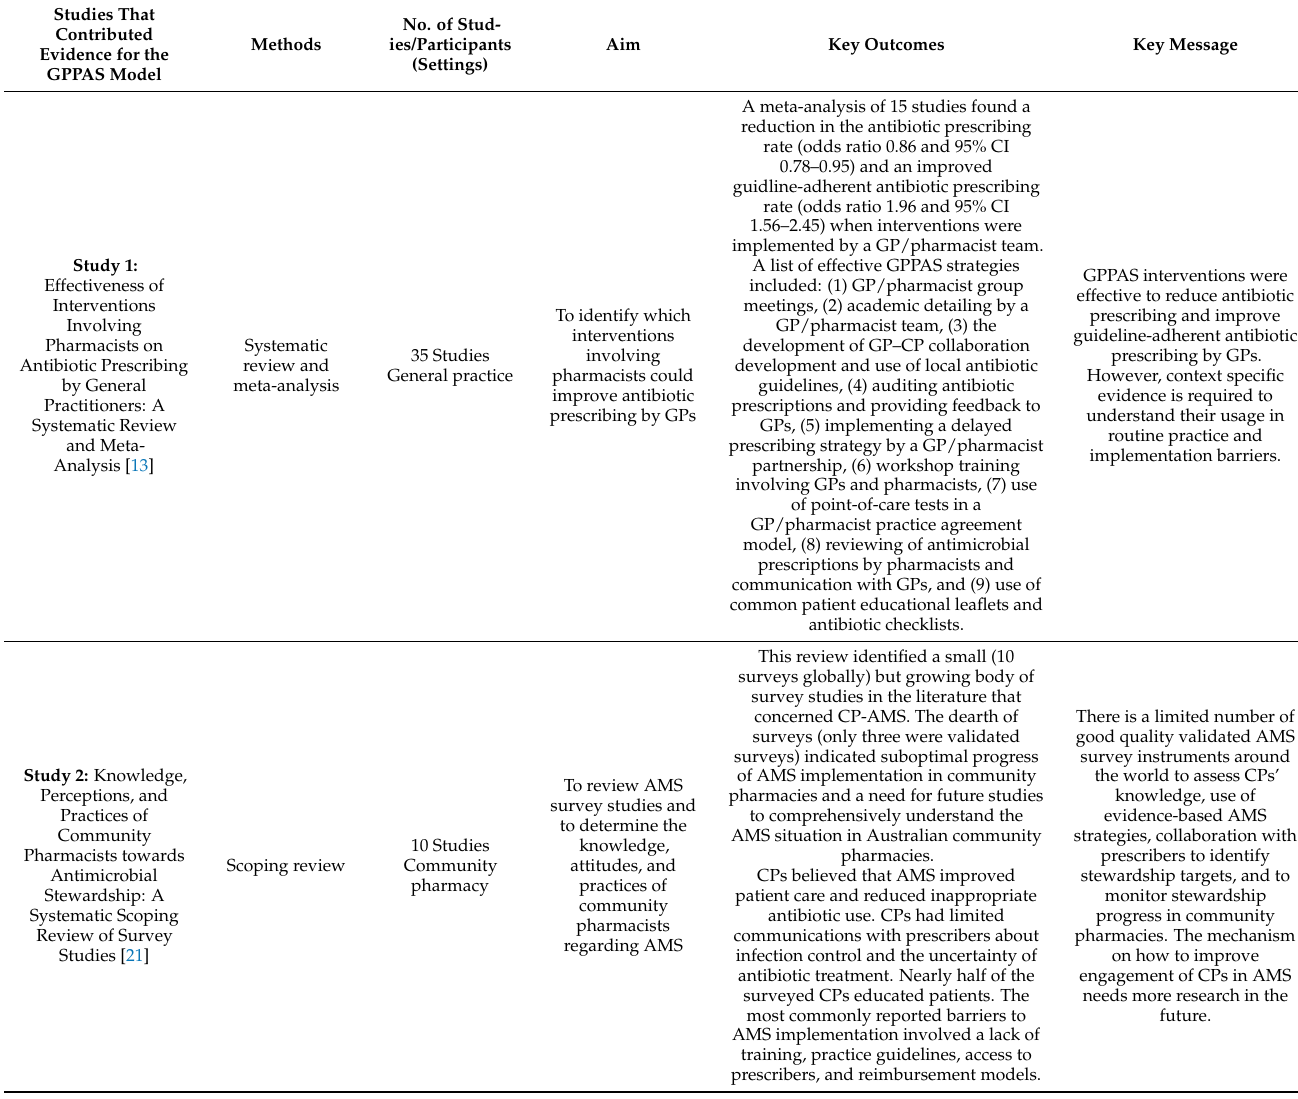
Table 1. Summary of key findings from seven individual studies that contributed evidence for the development of the GPPAS